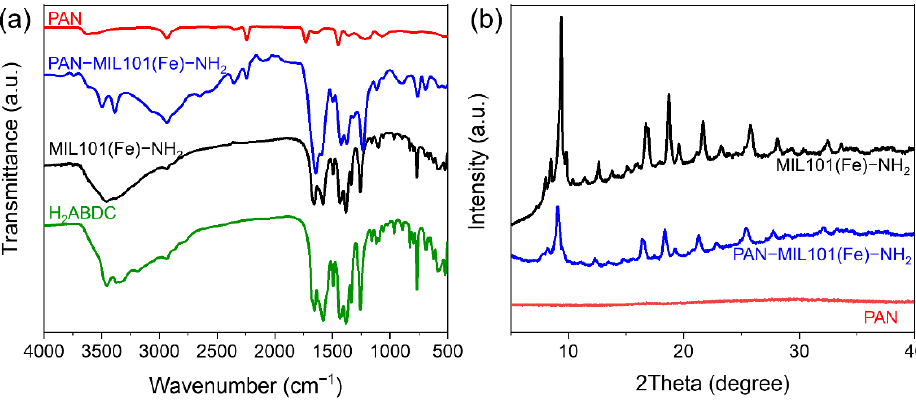
Figure 3. ( a ) FT-IR spectra of the PAN, PAN-MIL101(Fe)-NH 2 , MIL101(Fe)-NH 2 , and 2-amino-terephthalic acid. ( b ) XRD spectra of the PAN, PAN-MIL101(Fe)-NH 2 , and MIL101(Fe)-NH 2 . The XRD patterns of the PAN, PAN-MIL101(Fe)-NH 2 , and MIL101(Fe)-NH 2 are com-